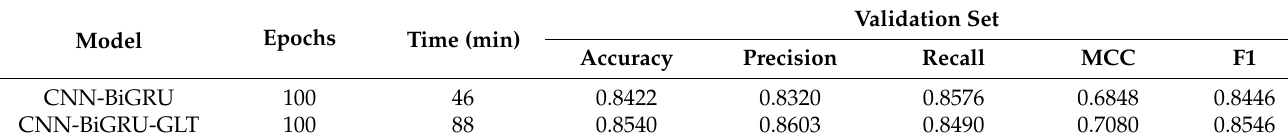
Figure 3. Comparison of the CNN-BiGRU-GLT model’s performance with traditional deep learning methods on validation set: ( A ) CNN-BiGRU-GLT and RNN performance comparison; ( B ) CNN-BiGRU-GLT and BiRNN performance comparison; ( C ) CNN-BiGRU-GLT and GRU performance comparison; ( D ) CNN-BiGRU-GLT and BiGRU performance comparison; ( E ) CNN-BiGRU-GLT and LSTM performance comparison; ( F ) CNN-BiGRU-GLT and BiLSTM performance comparison; ( G ) CNN-BiGRU-GLT and CNN-BiGRU performance comparison. Table 3. Comparison of BiGRU and CNN-BiGRU performance on validation set.